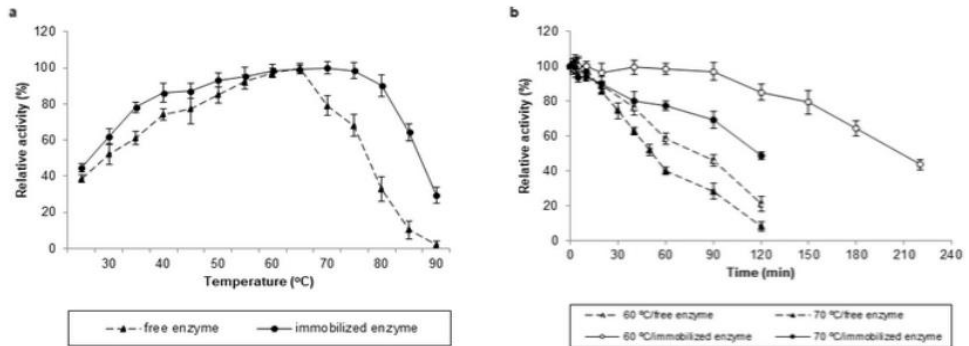
Figure 9. Optimal temperature and thermal stability of Tt LacA. Optimal temperature and stability profile at different temperatures for free ( ▲ , dotted line) and immobilized (●, continuous line) Tt LacA in copper alginate beads. ( a ) The optimal temperature was determined at a range from 25 – 90 °C, at optimal pH (i.e., 3). ( b ) The thermal stability was determined at different temperatures in 100 mM glycine-HCl buffer (pH 3.0); open and filled symbols represent the temperature to 60 and 70 °C, respectively.